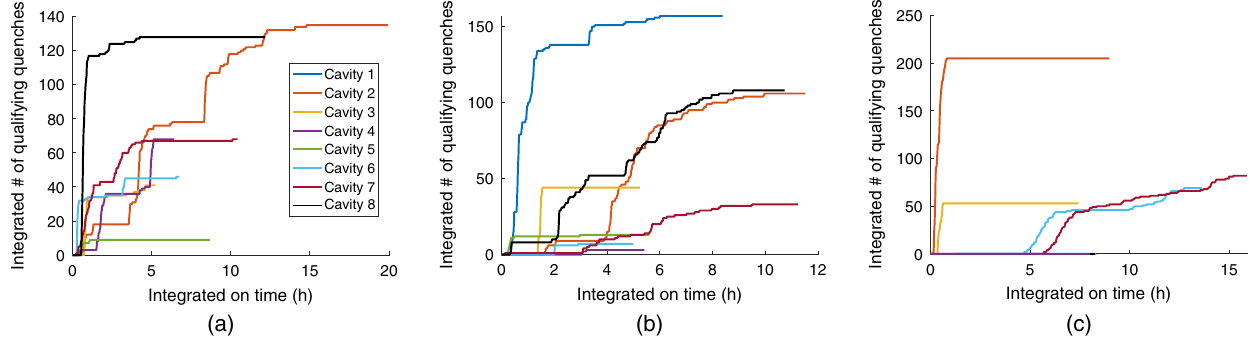
FIG. 10. The three plots show the number of MP quenches found for each cavity as a function of the integrated time that the cavity spent powered on. Plot (a) shows these results for the first cooldown, (b) for the second cooldown measured before plasma processing, and (c) for the after plasma processing